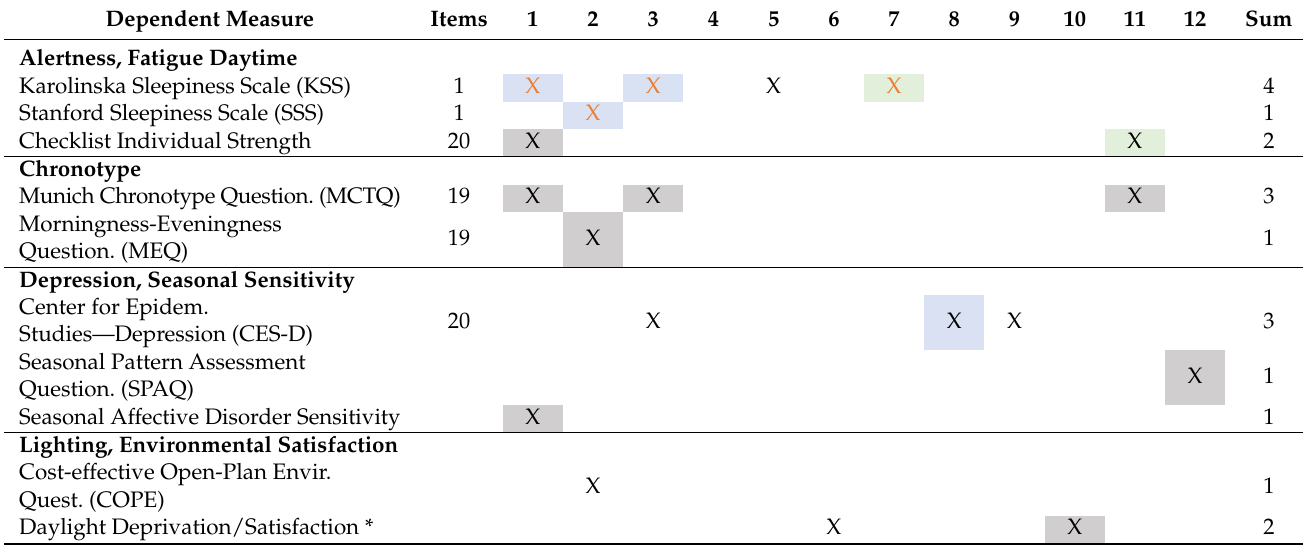
Table 3. Office field research since 2010: Summary of dependent measures and significant results.